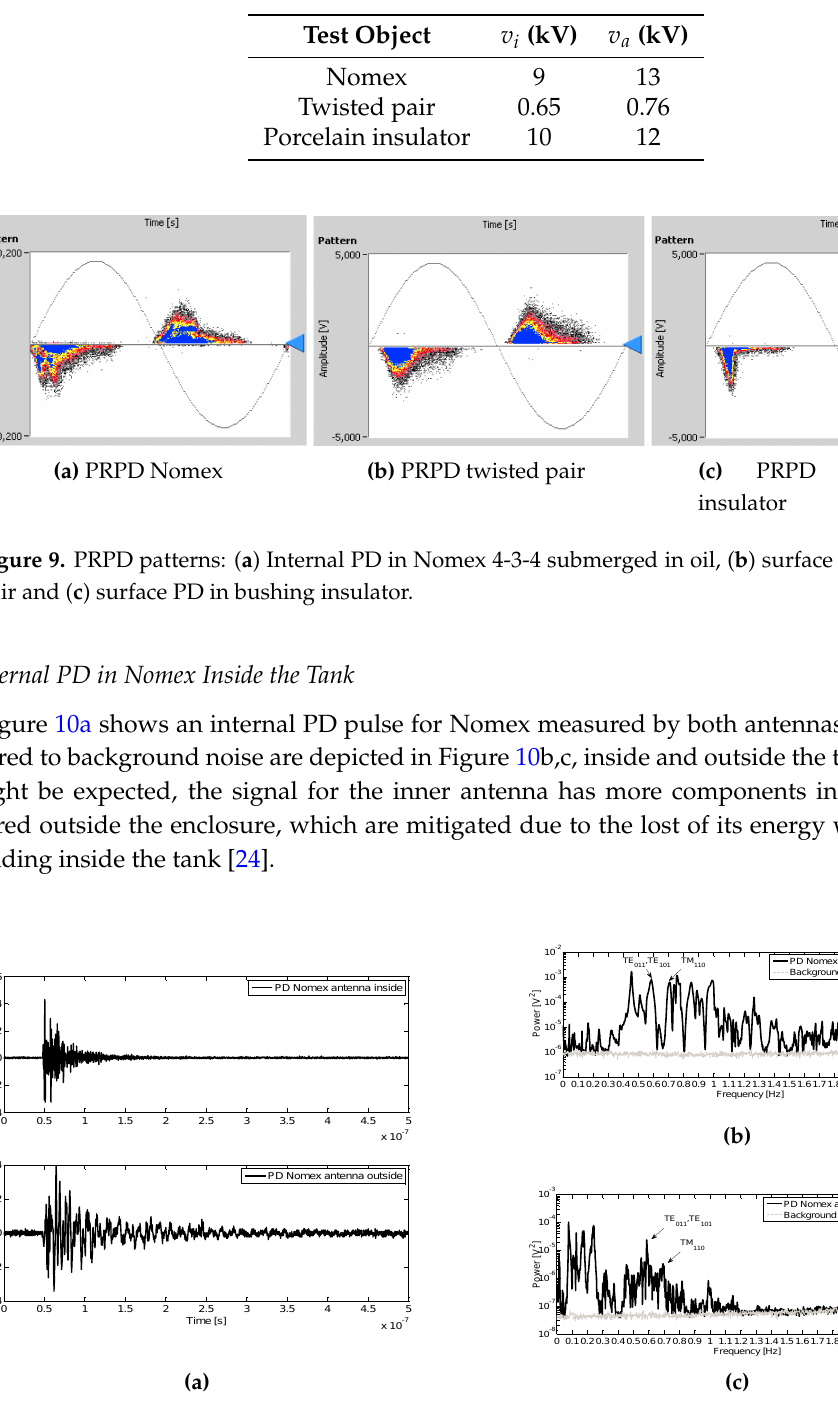
Figure 10. ( a ) Internal PD pulses in Nomex paper at 13 kV inside the enclosure acquired by the inner and outer antennas and their average power spectra compared with the noise inside ( b ) and outside ( c